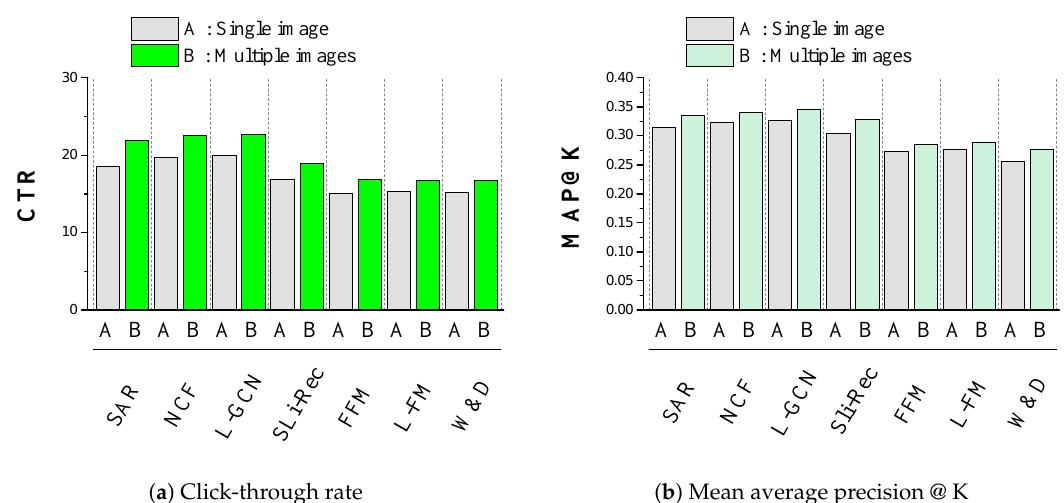
Figure 9. Visualization of A/B experiments for visual information ( Netflix dataset).